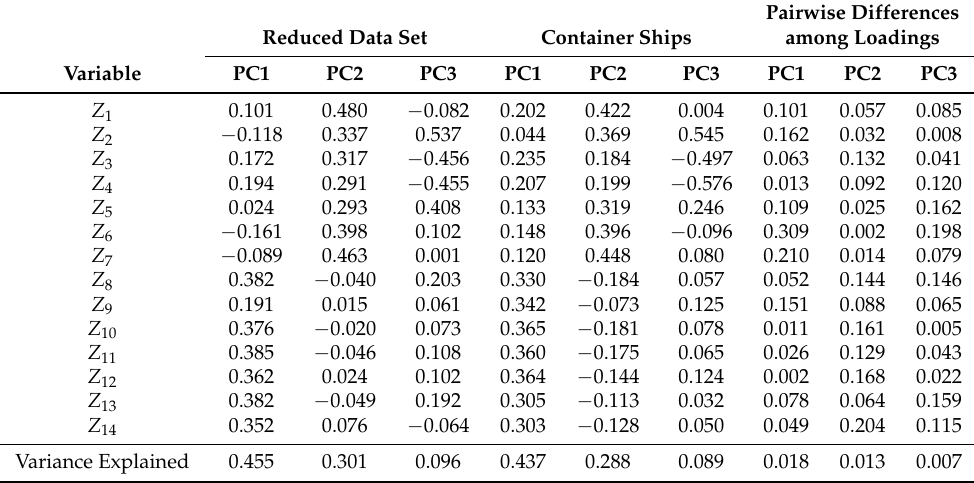
Table 4. PCA loadings for the first three PCs using the General Cargo ships (reduced data) and the Container ship data. The pairwise differences for the two analyses are presented in the last three